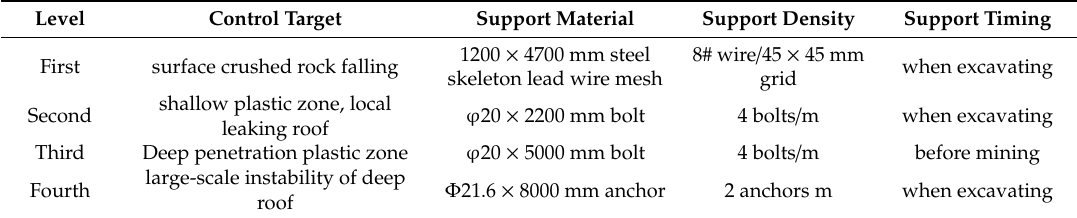
Table 5. Supporting programs and parameters in test roadway.